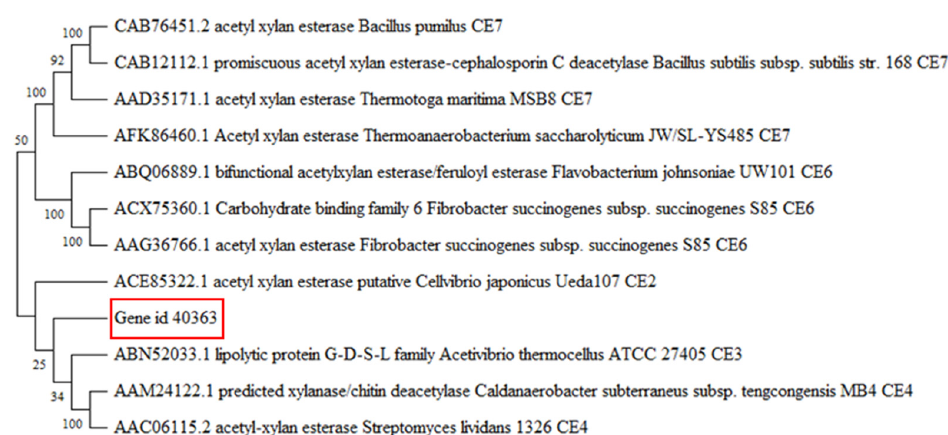
Figure 3. Phylogenetic tree. The nucleotide sequence of Gene_id_40363 was used to construct a phylogenetic tree with characterised proteins of CE family 1–7 with 3D models available in PDB. A Neighbour-Joining phylogenetic tree was constructed in MEGAX with 1000 bootstrap replicates. Proteins are identified with their GenBank number and described with their function(s) and CAZy classification.